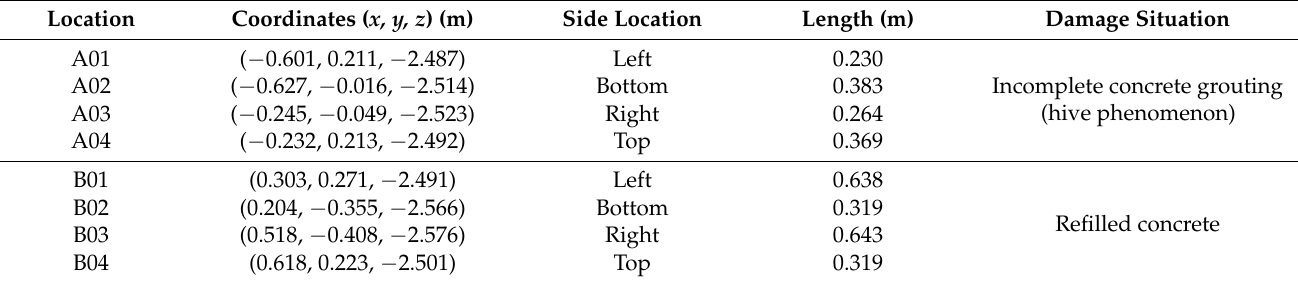
Table 9. Damage analysis at the bottom of the main beam.